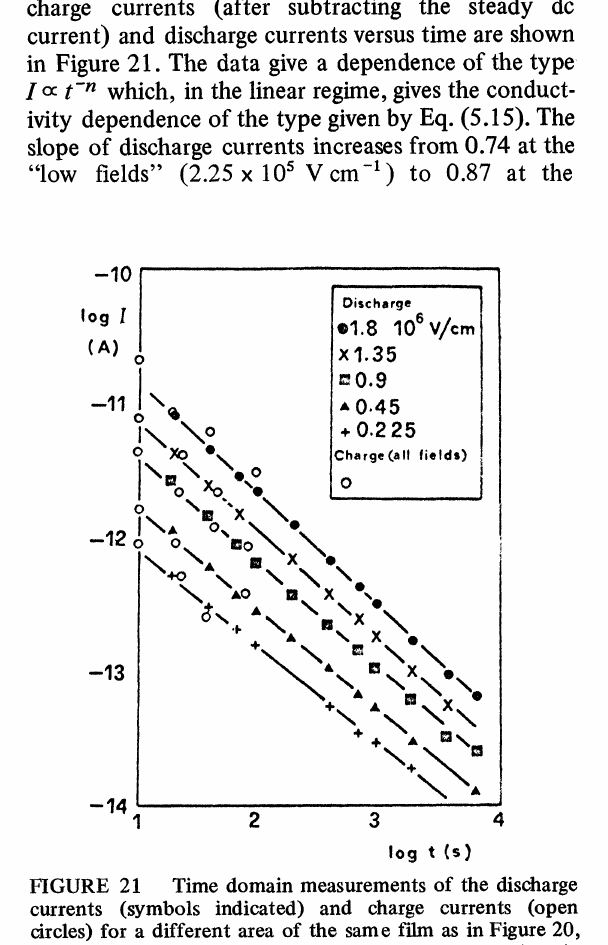
Time domain measurements of the discharge currents (symbols indicated) and charge currents (open drcles) for a different area of the same film as in Figure 20, for different charging fields. Charge currents have dc sub- tracted. The curves are log-log plots of vs. (time). [After Jonscher and Nathoo 96